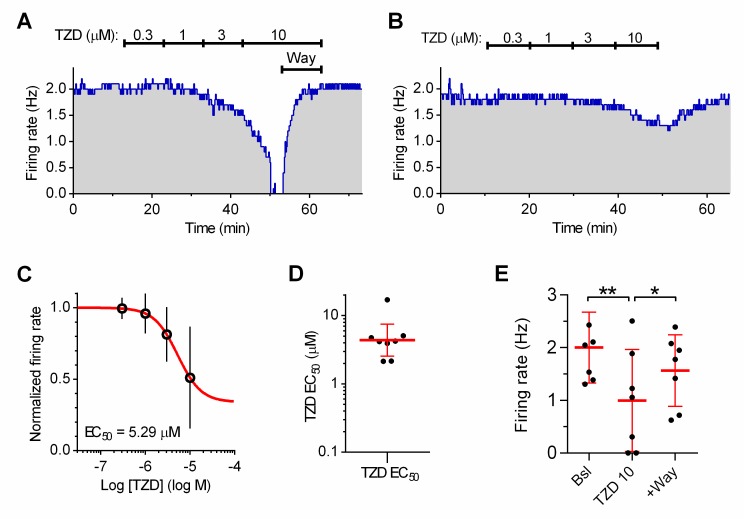
Activation of 5-HT1A receptors by trazodone in high phenylephrine.(A, B) Representative recordings of potent (A) and weak (B) trazodone (TZD effects on serotonergic neuron firing in the presence of 100 μM phenylephrine. Note that trazodone effect in (A) was fully antagonized by 20 nM Way-100635 (Way). (C) Average DRC obtained from all the experiments (n = 11). (D) Summary scatter plot of individual EC50 values from experiments in which complete DRC were obtained (n = 8). Data are normalized on Bsl firing rate. Red line is the best least-squares fit to the logistic equation. Symbols and error bars report the mean value ± SD. (E) Summary of the antagonism of Way-100635 on trazodone 10 μM (mean ± SD; n = 7; One-way RM ANOVA: F(2,6) = 11.80; p <0.0015). *p< 0.05, **p< 0.01 (One-Way RM ANOVA followed by a Tukey post-hoc test).